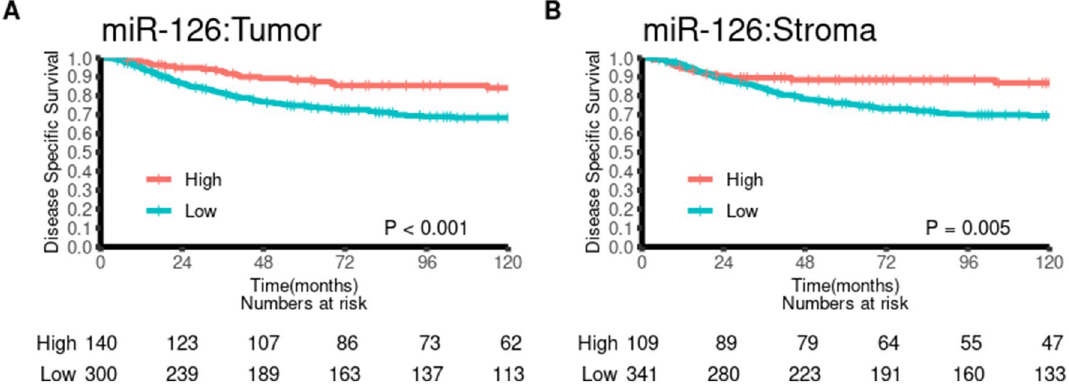
Figure 2. Disease-specific survival curves for tumor ( A ) and stromal ( B ) expression of miR-126, using the optimal cut-offs for each marker.